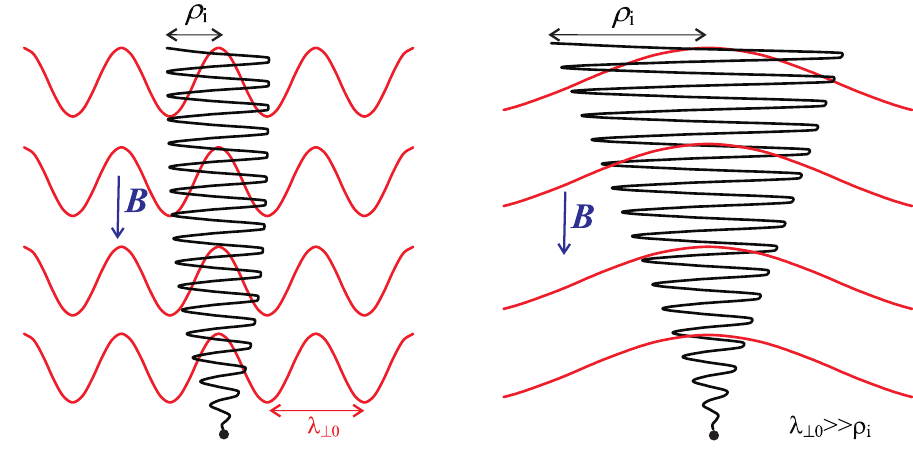
Fig. 5. Microscopic illustration of the gyrating motion of a single ion (black curve) across a wave field (red curves) transverse to the magnetic field ( B ) when (left) the ion gyroradius ρ i is of the order of the perpendicular wavelength λ ⊥ 0 of the structures, and (right) in the case of large perpendicular scale structures ( ρ i <<λ ⊥ 0 ) . Table 1. List and values of parameters of Monte Carlo simulations computed for the present study. Run Id. Residence time t D Heating rate at r = r 0 Spectral index